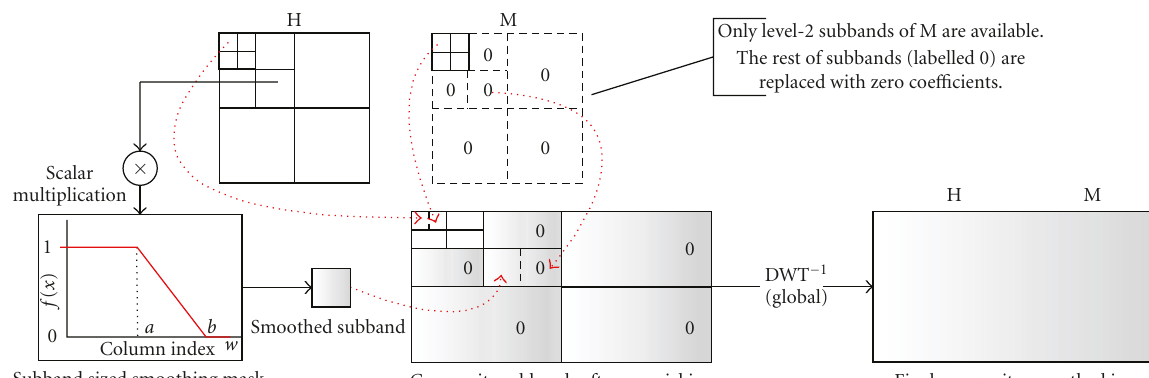
Figure 7: The proposed smoothing strategy in 1D.